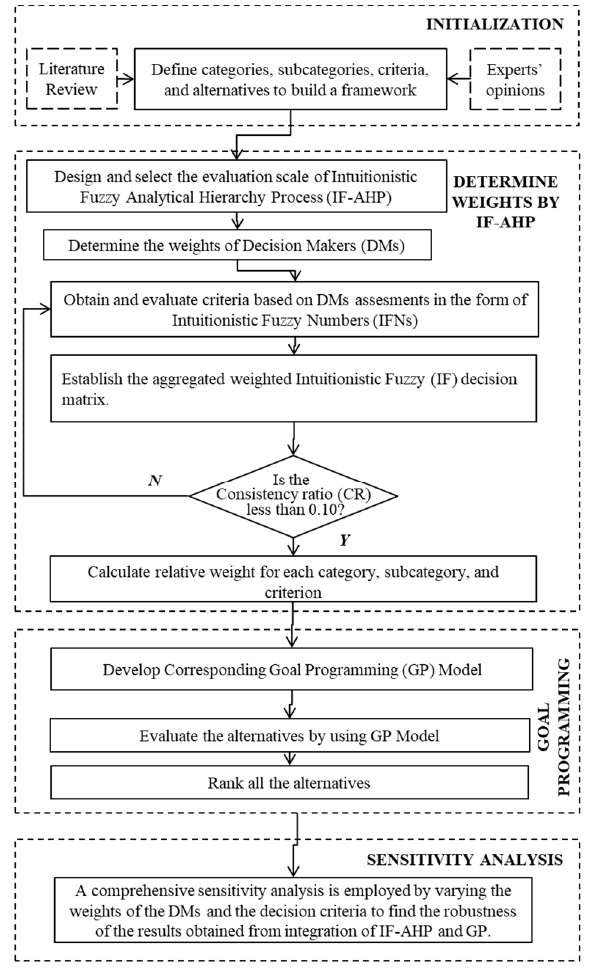
Figure 3. Proposed methodology.